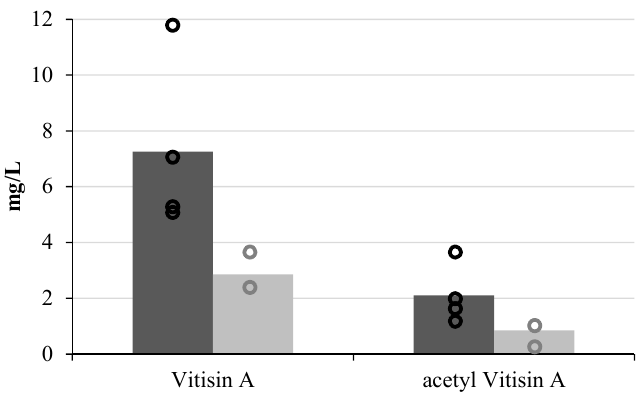
Figure 3. Formation of vitisin A and acetyl vitisin A during the fermentation with S. pombe (4 strains; dark grey bars) and Saccharomyces cerevisiae ( S. cerevisiae ) (2 strains; light grey bars). Bars are average concentrations, dots are single values for each strain (Adapted from